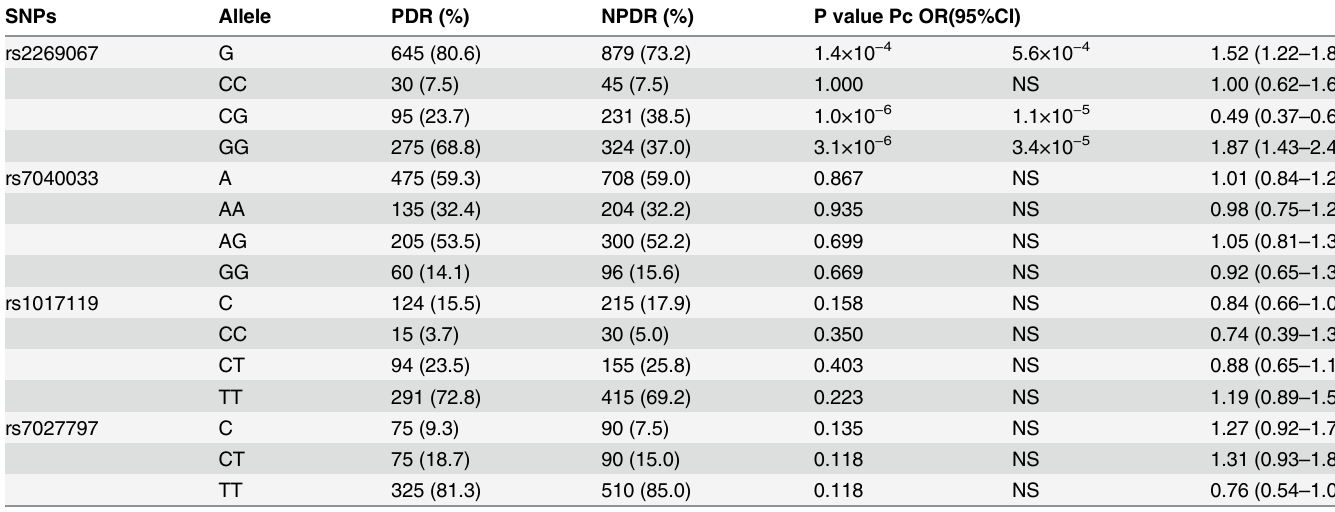
T2D: Type 2 diabetes; PDR: Proliferative diabetic retinopathy; NPDR, non-proliferative diabetic retinopathy; SNP, single-nucleotide polymorphism;